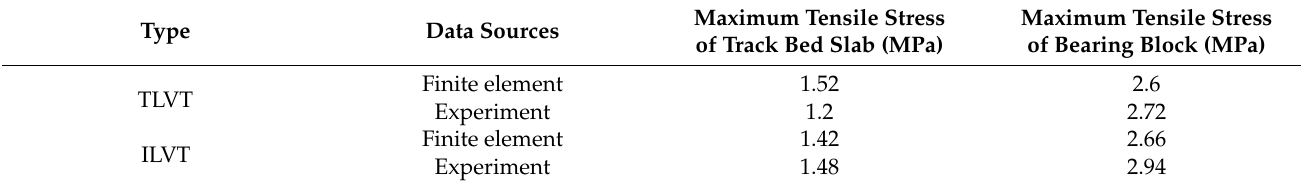
Table 5. Comparative analysis of mechanical performance research model and experiment.